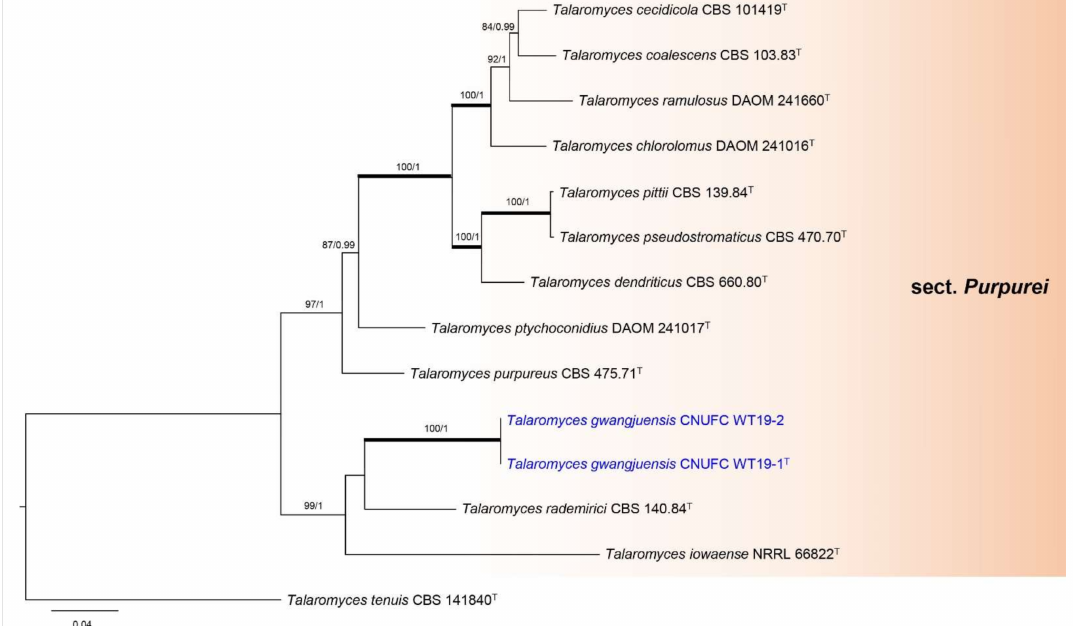
Figure 2. Phylogram generated from the Maximum Likelihood (RAxML) analysis based on the combined ITS, BenA , CaM , and RPB2 sequences data for species classified in Talaromyces section Purpurei . The branches with values = 100% ML BS and 1 PP are highlighted by thickened branches. The branches with values ≥ 70% ML BS and ≥ 0.95 PP indicated above or below branches. Talaromyces tenuis CBS 141840 was used as the outgroup. The newly generated sequences are indicated in blue. T = ex-type.